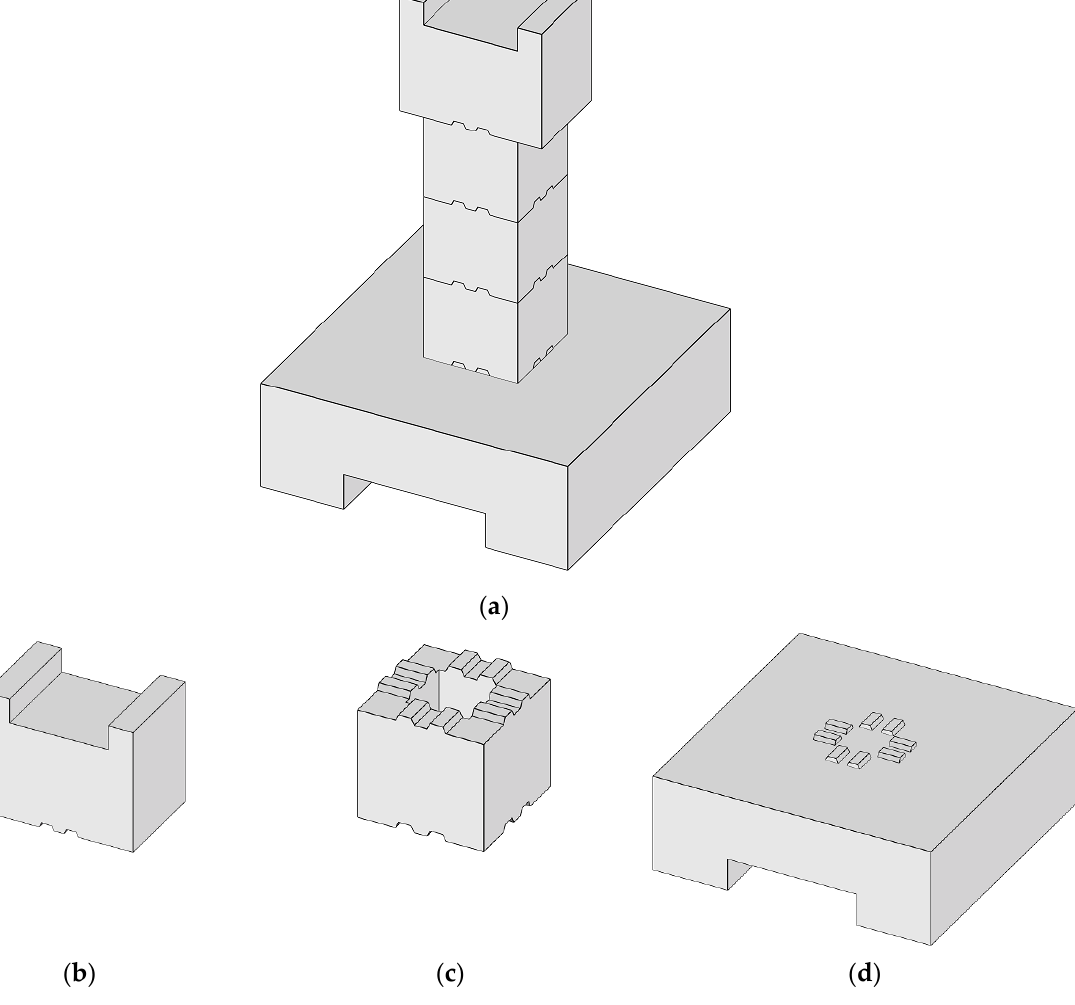
Figure 1. Specimen overview. ( a ) Segmental prefabricated bridge piers. ( b ) Load segment. ( c ) Segment. ( d ) Bearing platform.